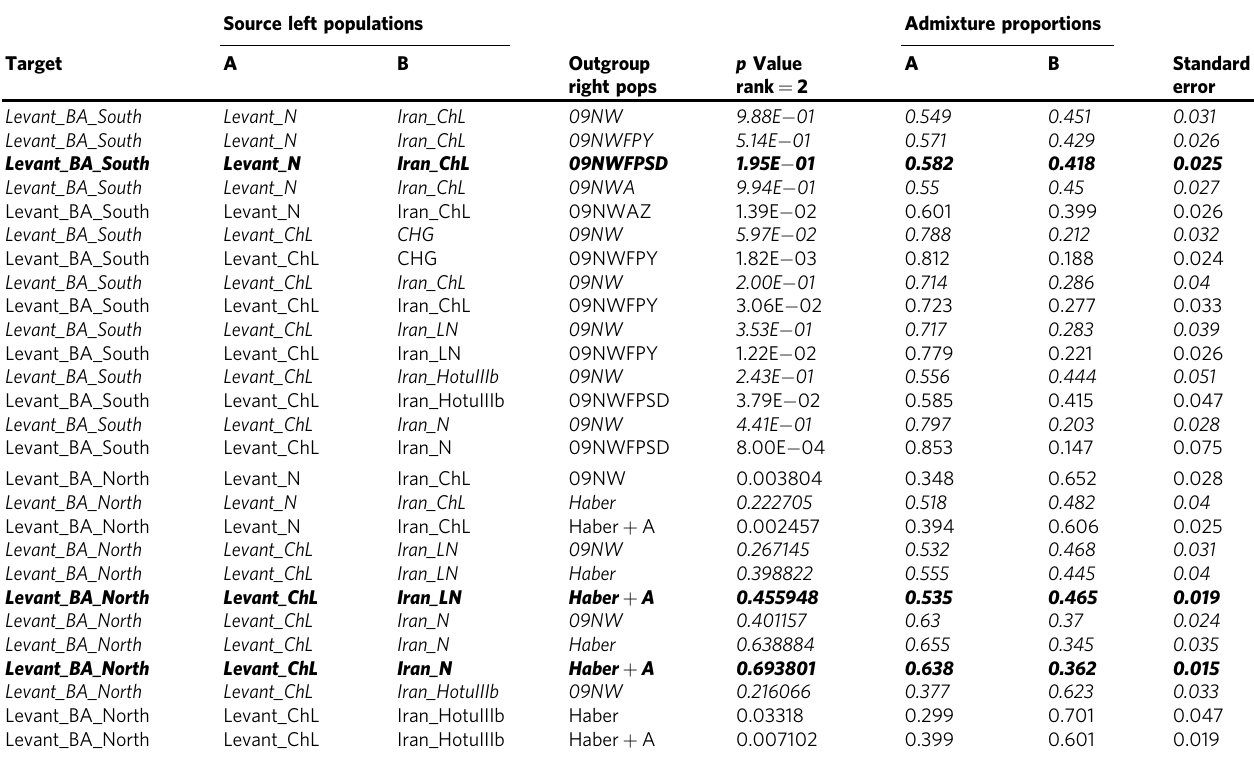
Table 2 Modeling Levant_BA_South and Levant_BA_North as a mixture of Levant_ChL and an ancient population,